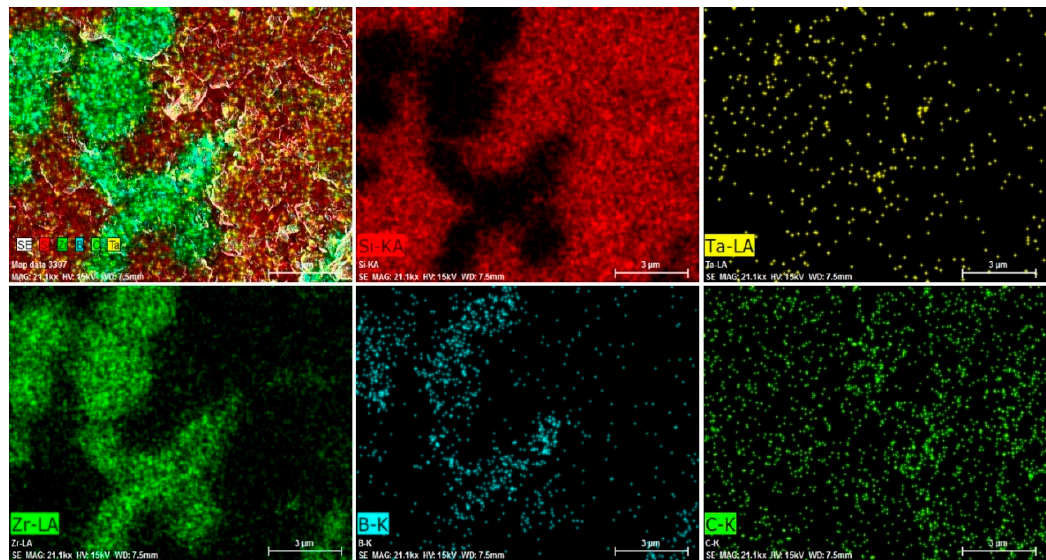
Figure 8. Energy-dispersive X-ray spectroscopy (EDS) map of ZrB 2 –SiC–TaC.